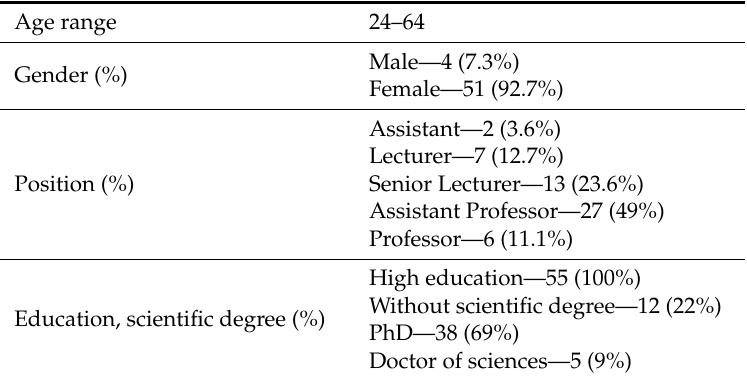
Table 3. Respondents’ characteristics.